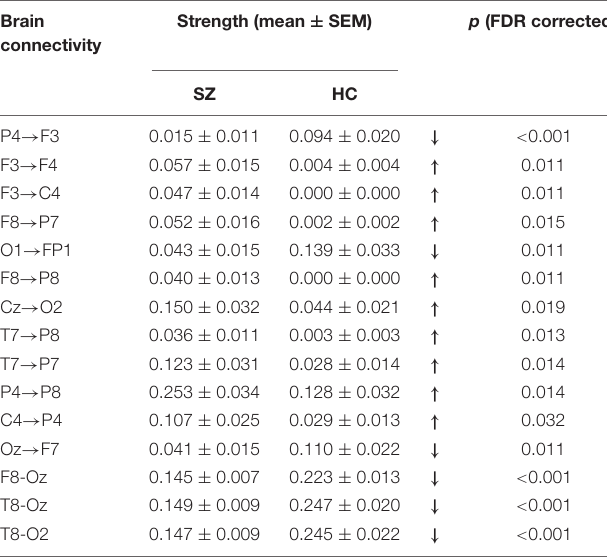
TABLE 2 | The brain connectivity values of the selected 12 PDC and three PLI connectivity features and the result of statistical comparison between SZ patients and